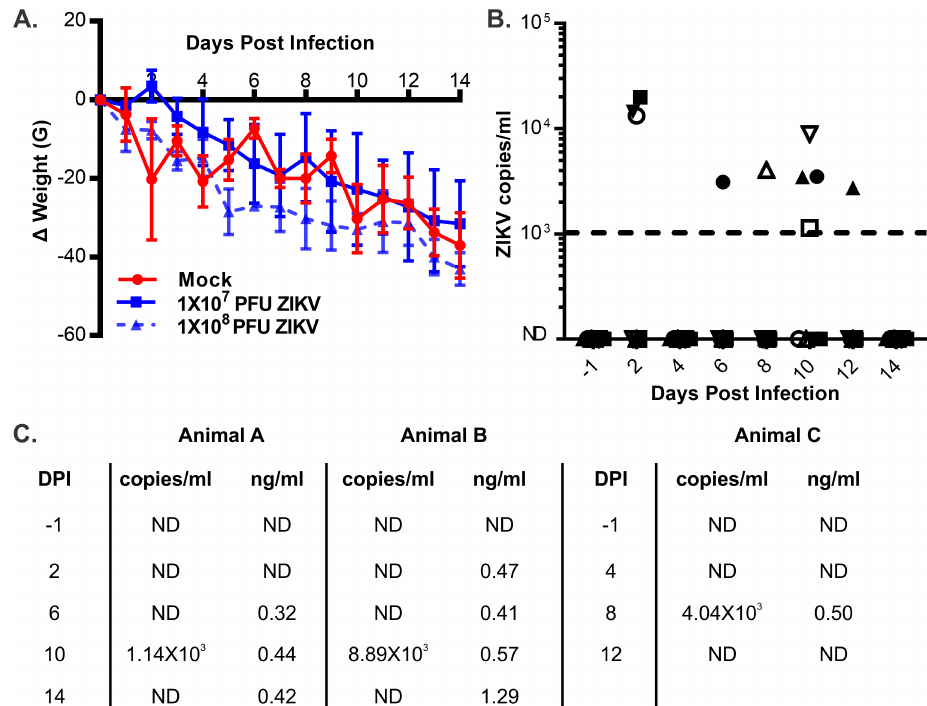
Fig 2. ZIKV infection of non-pregnant guinea pigs. Groups of guineapigs (N = 4) were infected with 1x10 7 or 1X10 8 PFU of ZIKV or sham injected. (A) The weight changeof experimentally challenged guineapigs over time was recorded. The mean weight change in each group of challengedanimalsand the standarderror at each time point is plotted. (B) Viremia in wholeblood from challengedguineapigs was quantifiedusing qRT-PCR. Solid symbols indicate animalschallengedwith 1X10 7 PFU; opensymbols indicateanimals challenged with 1X10 8 PFU. (C) Select plasma samples from guineapigs challenged with 1X10 8 PFU of ZIKV were examinedusing a ZIKV NS1 ELISA. The numberof ZIKV genomecopies/ml and the magnitude of antigenemia, as assessed in ng/ml NS1 in blood or plasma from each animal at the indicatedtime point post- infectionare shown. ND: not